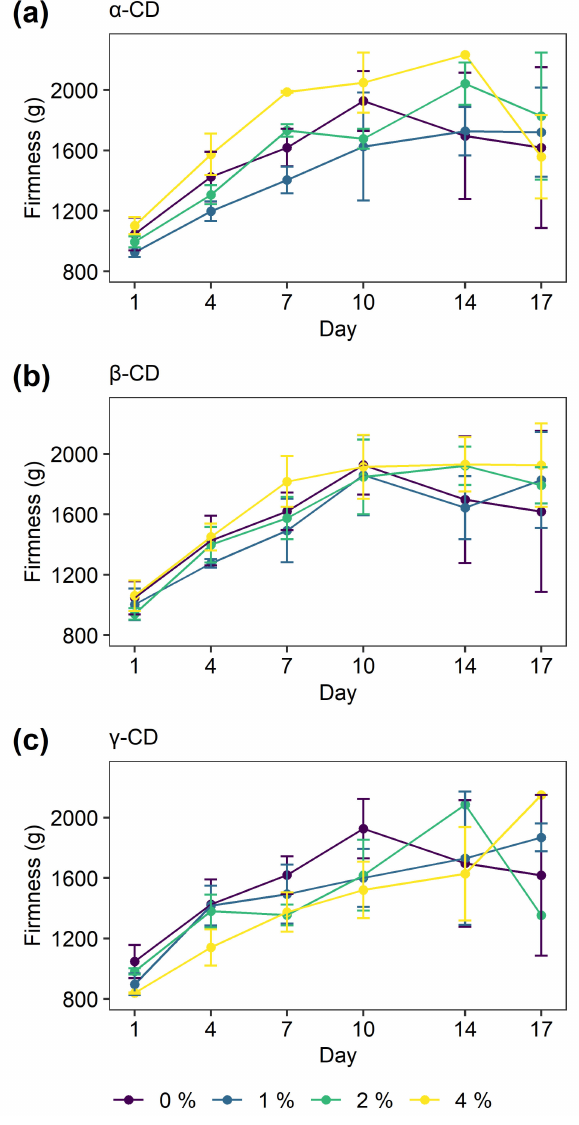
Figure 4. Firmness of bread without and with the addition of α -CD ( a ), β -CD ( b ), and γ -CD ( c ) for different storage time. The error bars indicate the standard